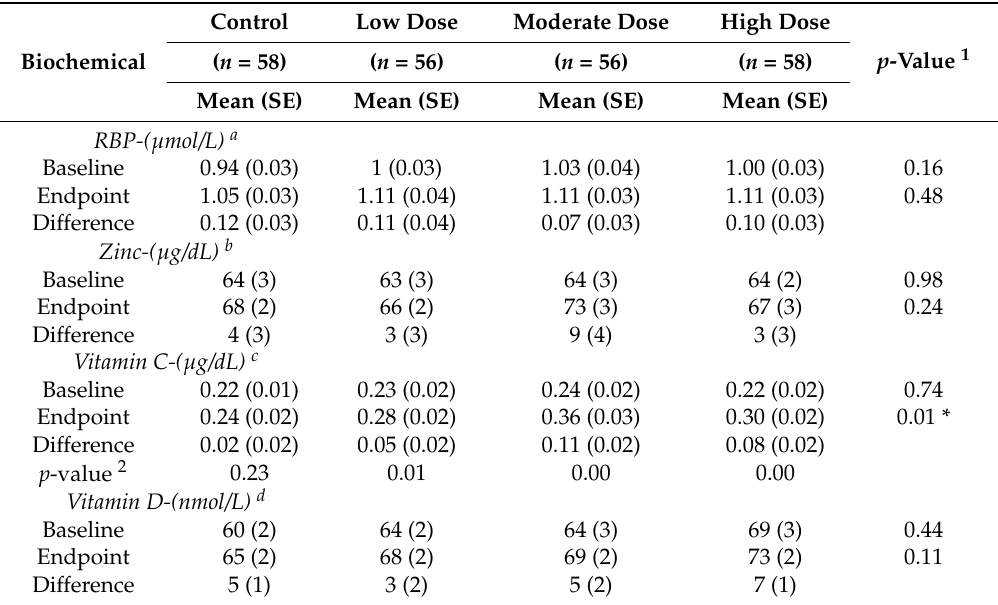
Table 4. Mean of secondary biomarkers of study children by group by period. Control Low Biochemical